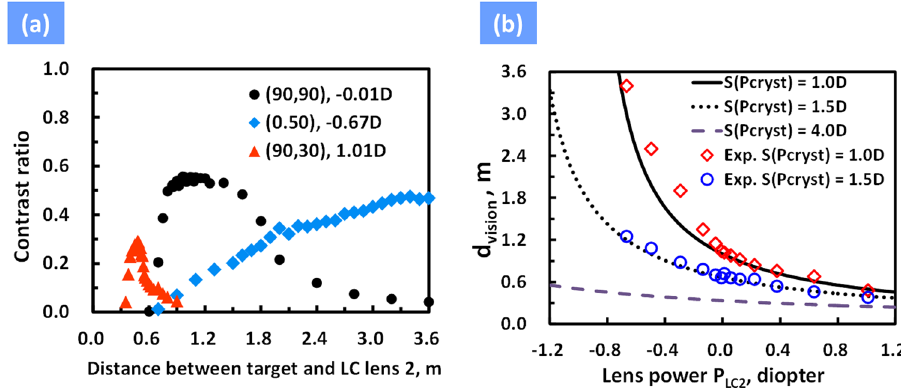
Figure 5. ( a ) Contrast ratio as the function of distance between target and “LC lens 2” at different voltage pair( V 1 , V 2 ) of “LC lens 2”. ( b ) d vision as the function of lens power of “LC lens 2” at different S(P cryst )